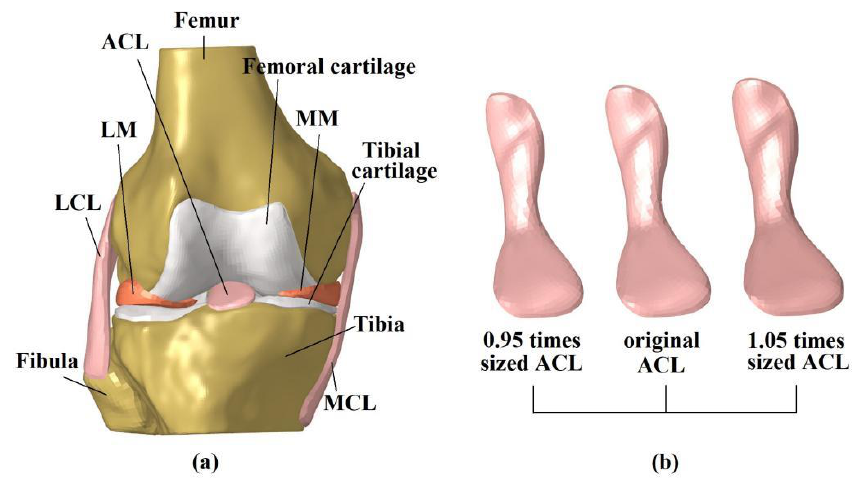
Figure 1. 3D model of the intact knee ( a ), ACL models showing different sizes ( b ). LM: lateral meniscus; MM: medial meniscus; LCL: lateral collateral ligament; MCL: medial collateral ligament.